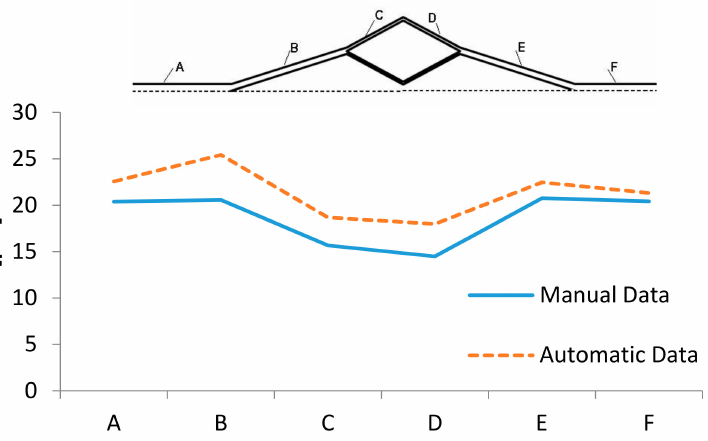
Figure 17. Comparison between the manual and the automatic data, taken in the regions A to